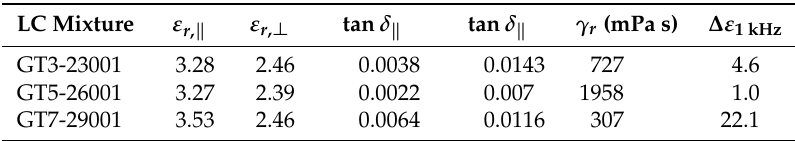
Table 1. Different LC mixtures used in this manuscript and their corresponding properties. Data provided by Merck KGaA at